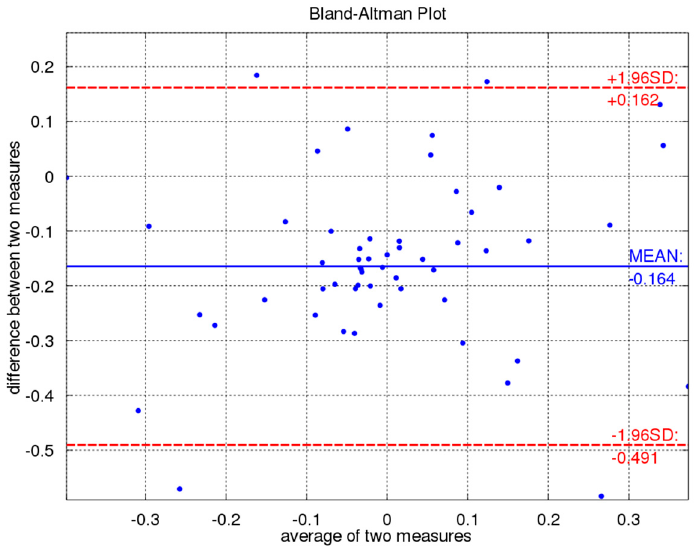
Figure 5. The correlation between the severity of the actual and predicted cases of crystal structures from diffraction photography of the surface measured using the Bland ‐ Altman Plot which is a difference against average.